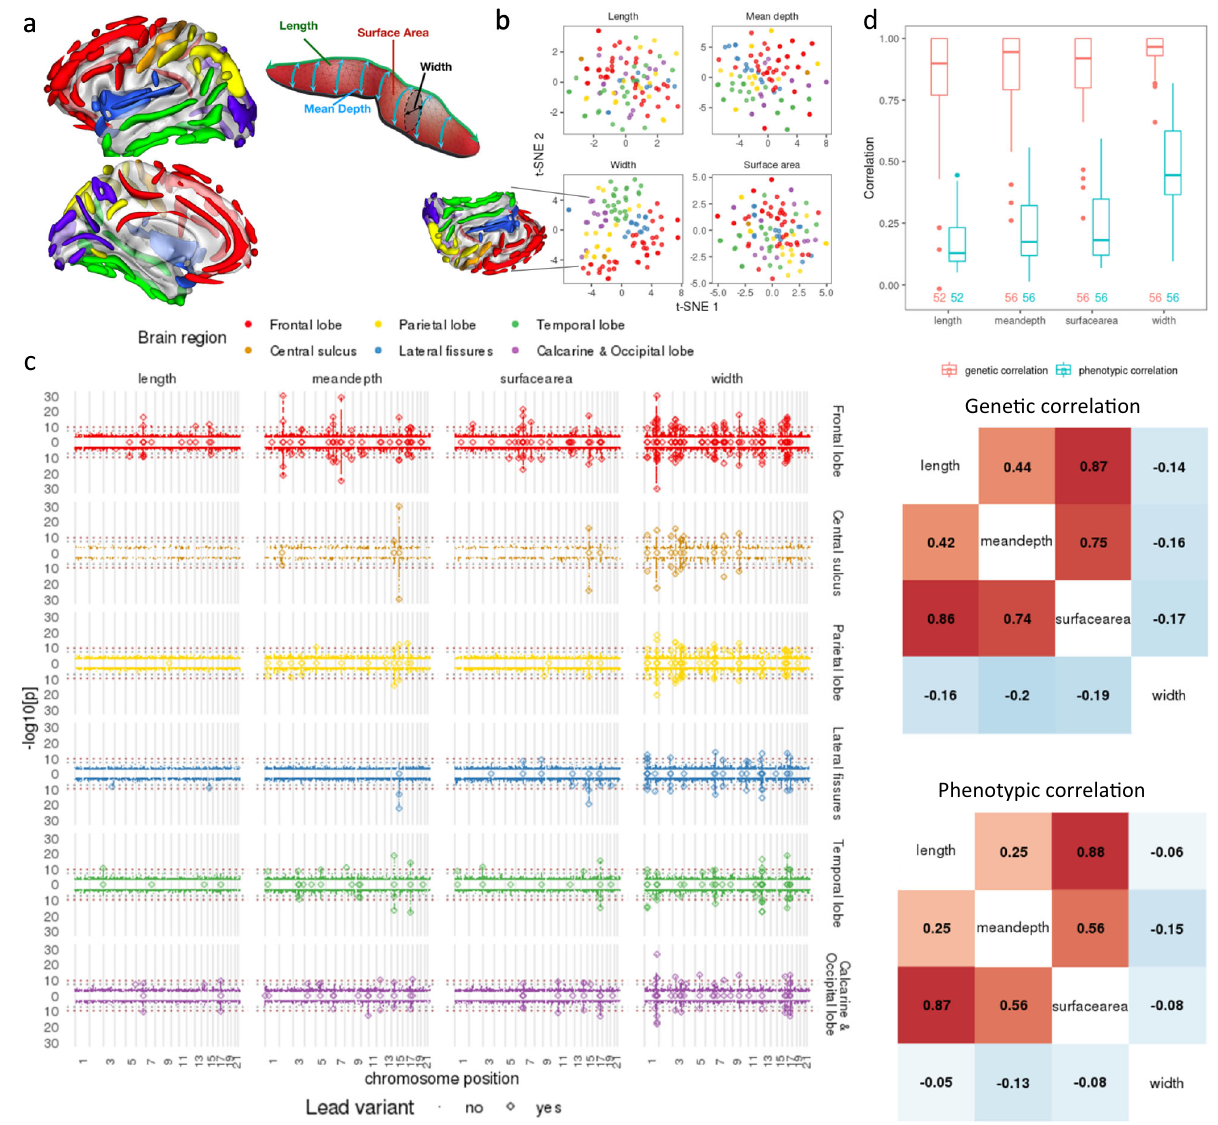
Fig. 1 | Summary of brain sulcal association results. a Schematic of brain sulcal folds and shape parameters. Brain region legend corresponds to colours in fi gures a – c . b t-SNE of regional brain sulcal measures for each shape parameter. c Manhattan plots by brain region, shape parameter and side. Diamonds indicate lead associations that replicated ( p <0.05). N =26,530 (discovery) and n =13,639 (replication) biologically independent sample measures. Points above 0 in the y-axis in each plot refers to associations with left sided sulcal measures, below 0 withrightsidedmeasures.Diamondsalong0inthey-axisindicateleadassociations for bilateral sulcal measures. Dashed horizonal line indicate GWAS signi fi cance thresholds (grey: p =5×10 − 8 , darkred: p =2×10 − 10 ).High resolution of the fi gureis